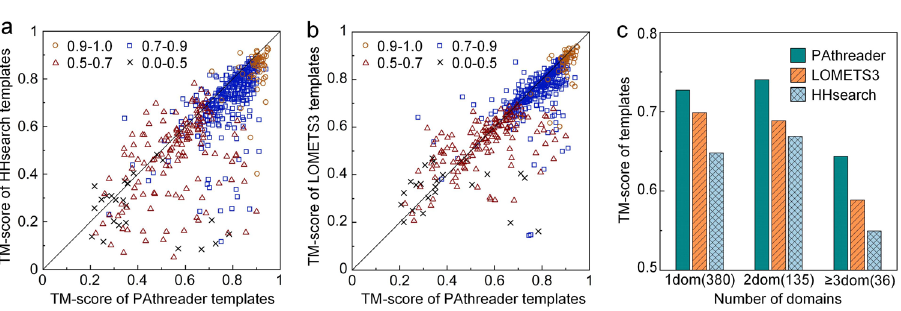
Fig. 2 Performance of PAthreader for template recognition. a , b Head-to-head TM-score comparison of PAthreader with HHsearch and LOMETS3 at different dif fi culty levels. c Average TM-score on single-domain and 2-domain and ≥ 3-domain proteins, with corresponding protein numbers in